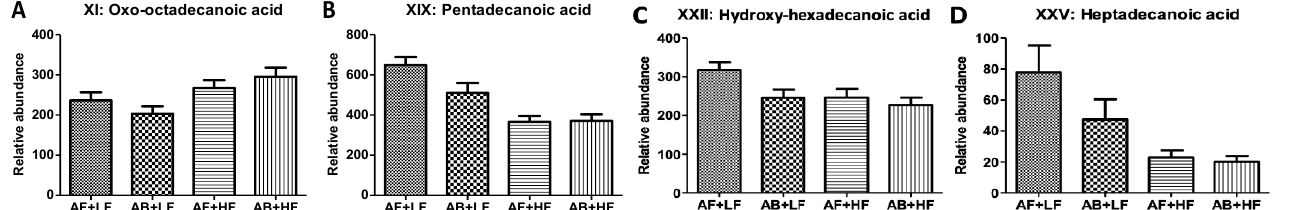
Figure 3. Effects of antibiotic and fiber treatments on free fatty acids in feces. ( A ) Oxo-octadecanoic acid, ( B ) Pentadecanoic acid, ( C ) Hydroxy-hexadecenoic acid, ( D ) Heptadecanoic acid. p -values are presented in Table 3.